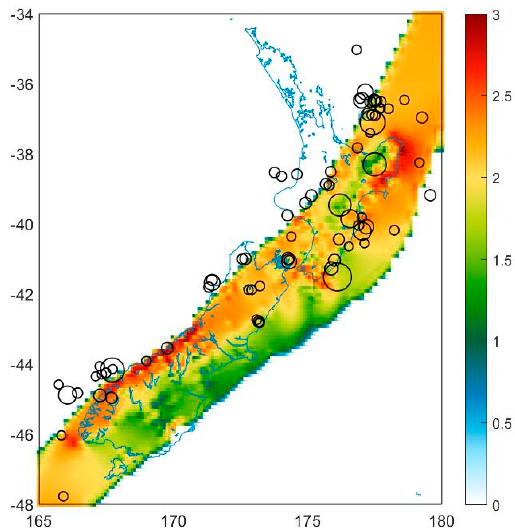
Figure 8. Spatial distribution of GSS and target earthquakes during 1951–1962.